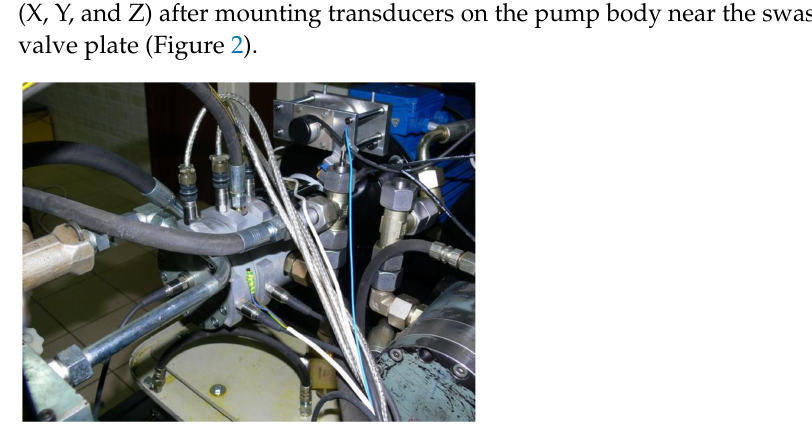
Figure 2. View of the vibration transducers mounted on the body of the tested